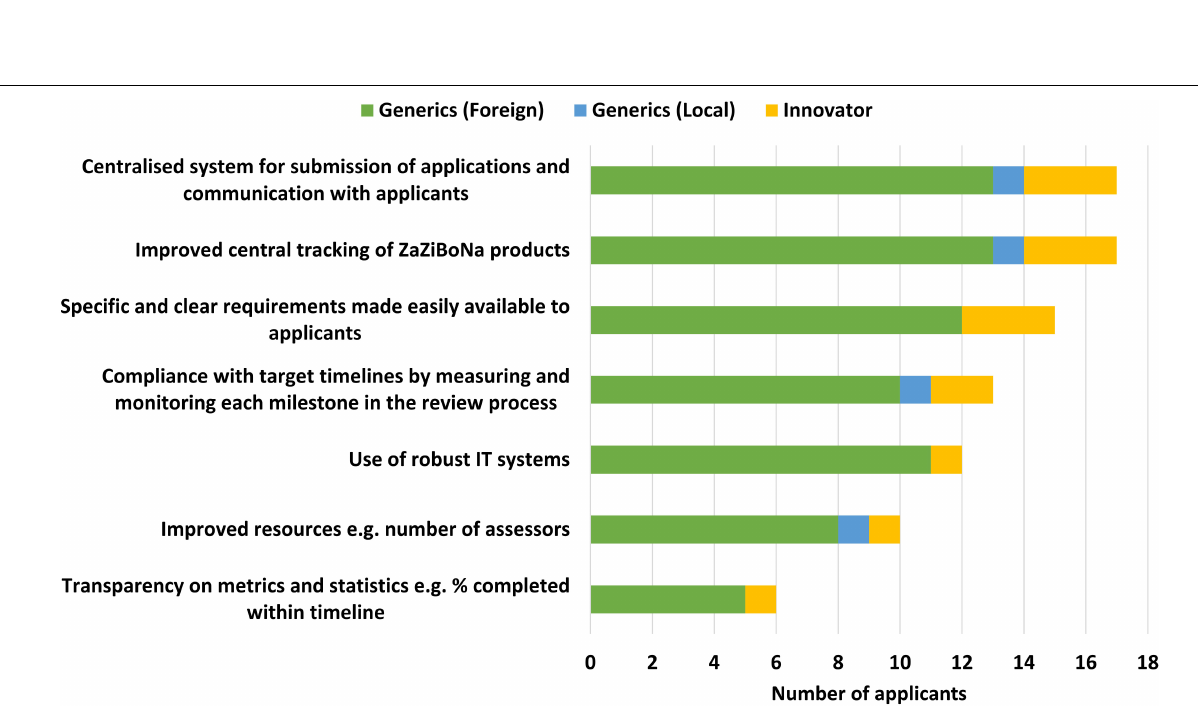
Frontiers in Medicine |